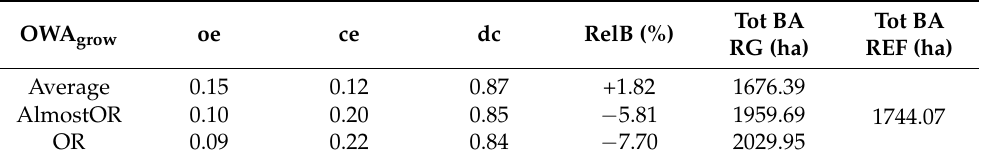
Table 5. Accuracy metrics (oe = omission error, ce = commission error, dc = Dice coefficient, relB = relative bias) over the Vesuvius site for the three (OWA Average , OWA AlmostOR and OWA OR ) growing layers. The total amount of burned area from the algorithm (Tot BA RG) and the reference (Tot BA REF) are also given.